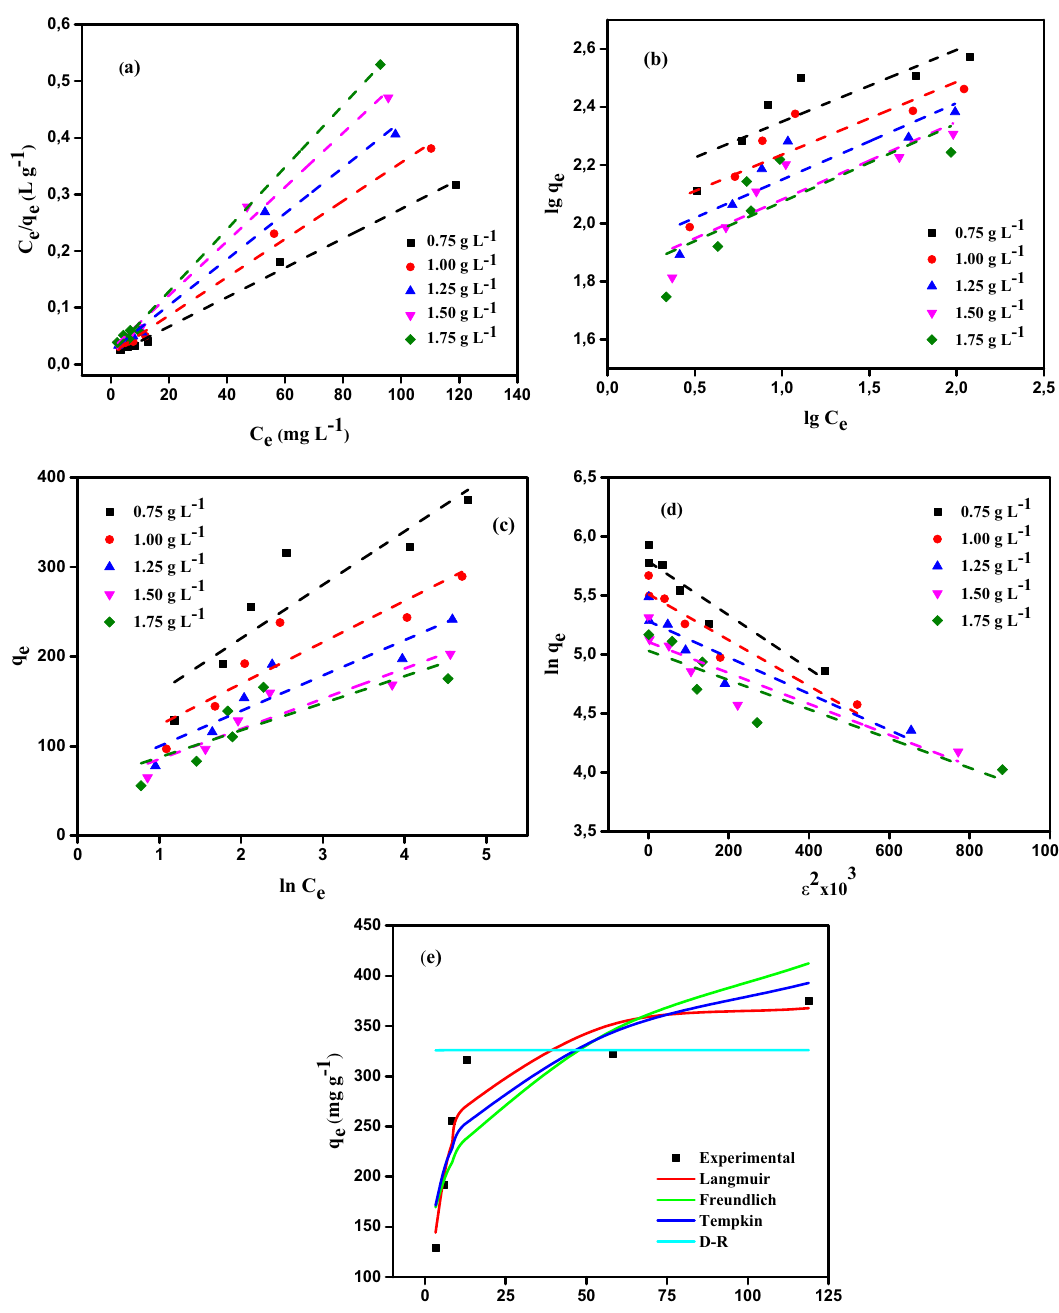
Figure 10. ( a ) Linearized Langmuir, ( b ) Freundlich, ( c ) Temkin, ( d ) Dubinin-Radushkevich isotherms profiles for AY11 dye at (25 ± 2) °C at starting concentrations (100–400 mg L –1 ) on MBT doses (0.75–1.75 g L –1 ). ( e ) When AY11 dye was used at a starting concentration of 100–400 mg L –1 on an MBT dose of 0.75 g L –1 , the isotherm profiles were compared between the measured and predicted isotherms profiles at RT (24 ± 2